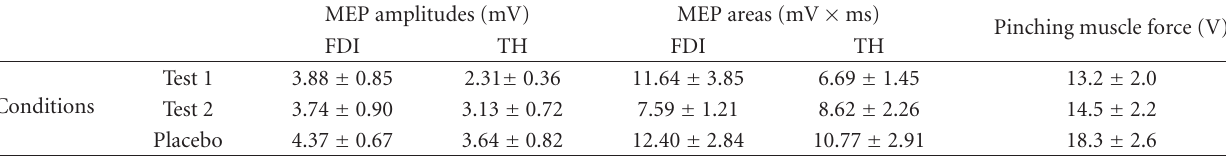
Table 1: MEP sizes and pinching muscle force before TMS with MVC under each condition.